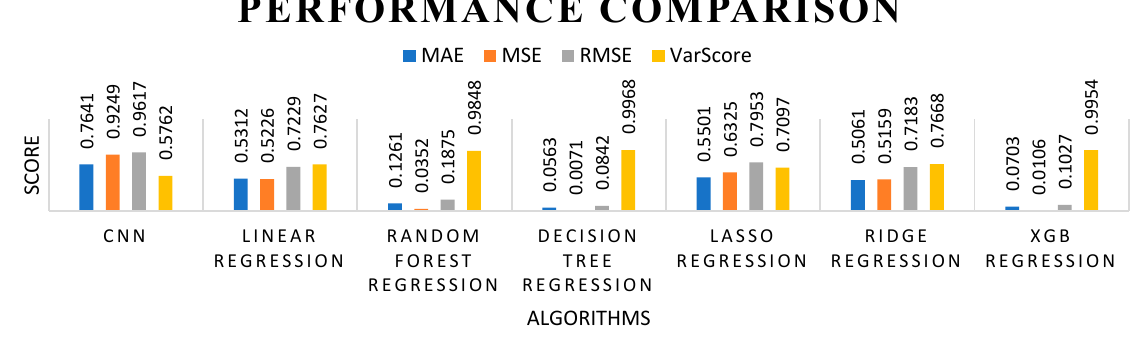
Figure 15. Comparative bar chart for seven algorithms.